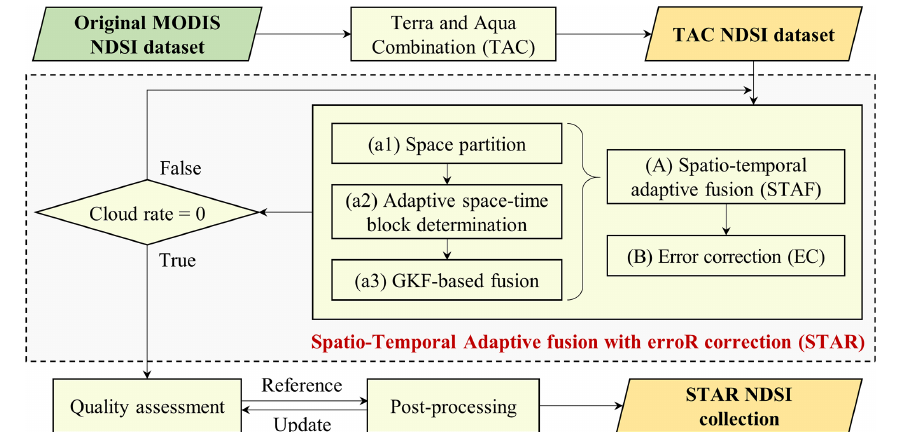
Figure 2. Schematic representation of the generation procedure of STAR NDSI collection.